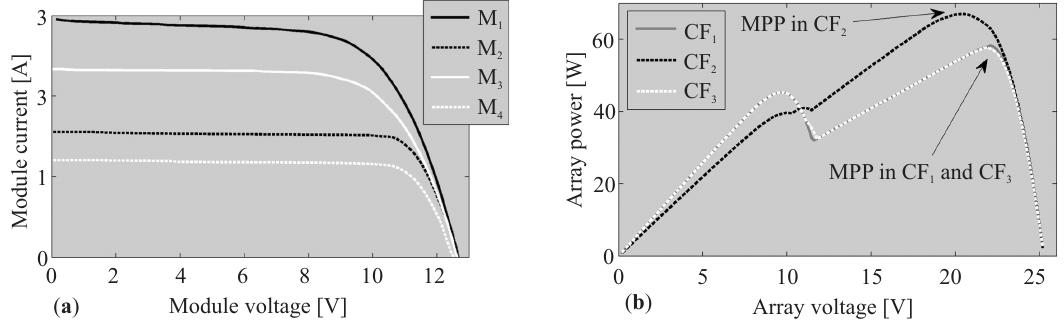
Figure 4. ( a ): I-V curves of M 1 , M 2 , M 3 and M 4 . ( b ): P-V curves of CF 1 , CF 2 and CF 3